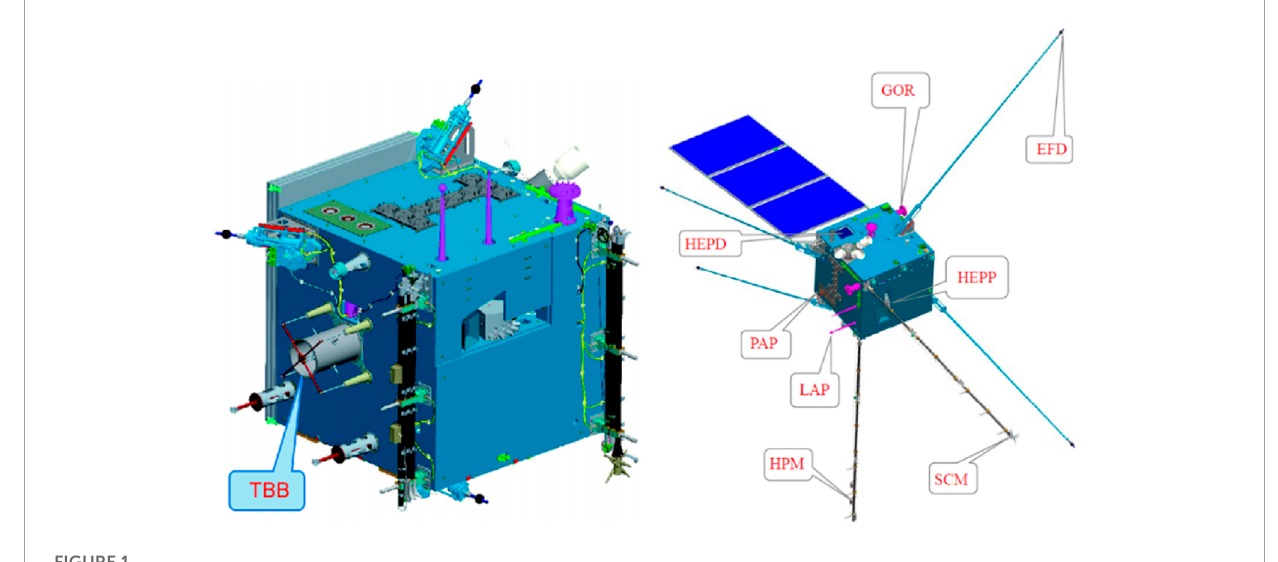
FIGURE 1 CSES-01 configuration {adapted from [Shen et al. (2018)]}.